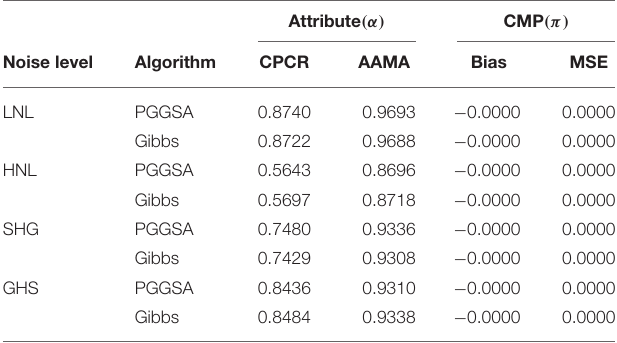
TABLE 5 | Evaluating accuracy of attribute and class membership probability parameter estimations using PGGSA and Gibbs algorithm in the simulation study 4.